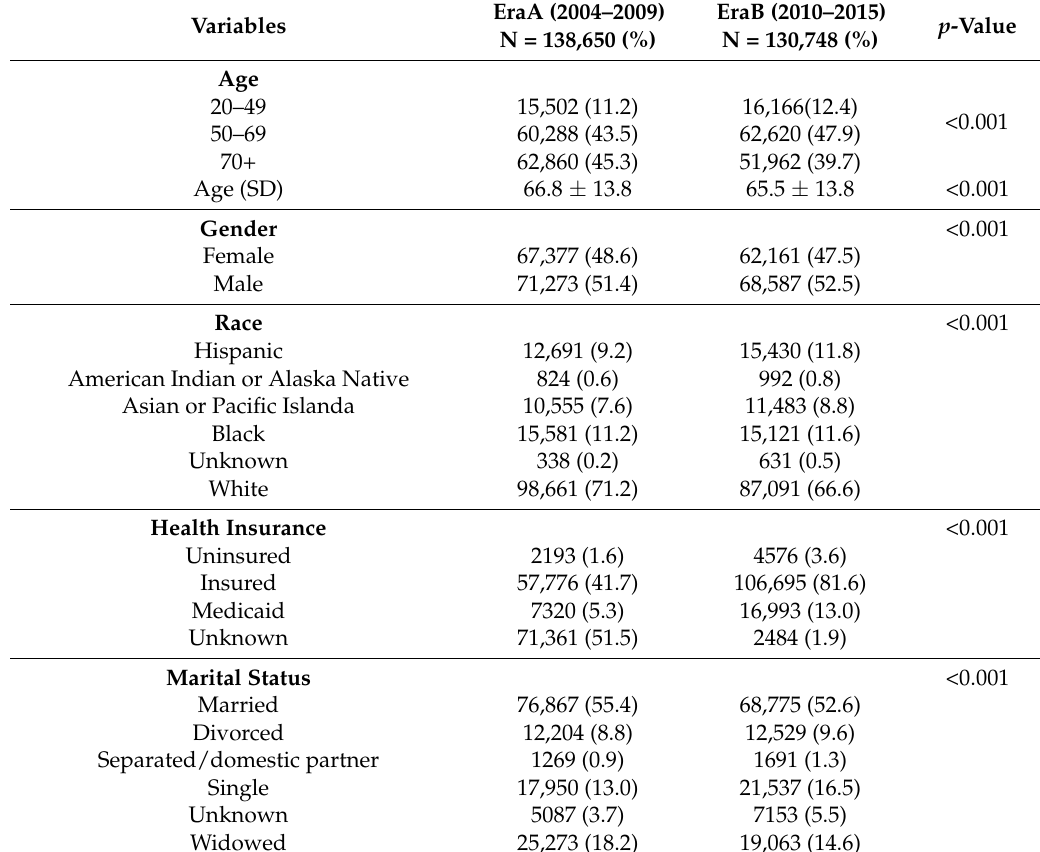
Table 1. Demographic and tumor